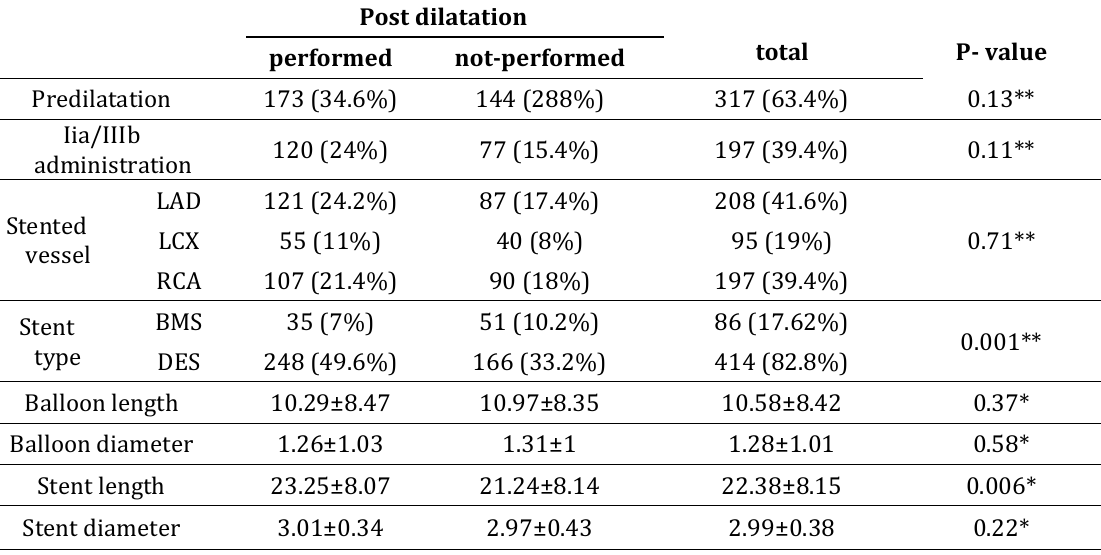
Table 2. Patients’ angioplasty findings according to post dilata tion intervention